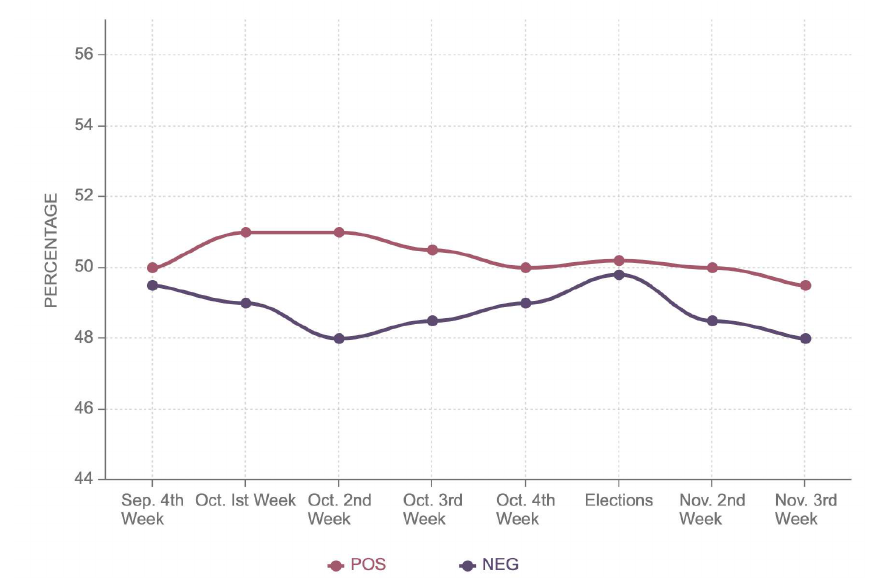
Figure 12. Graphs of positive and negative sentiments of Joe Biden in